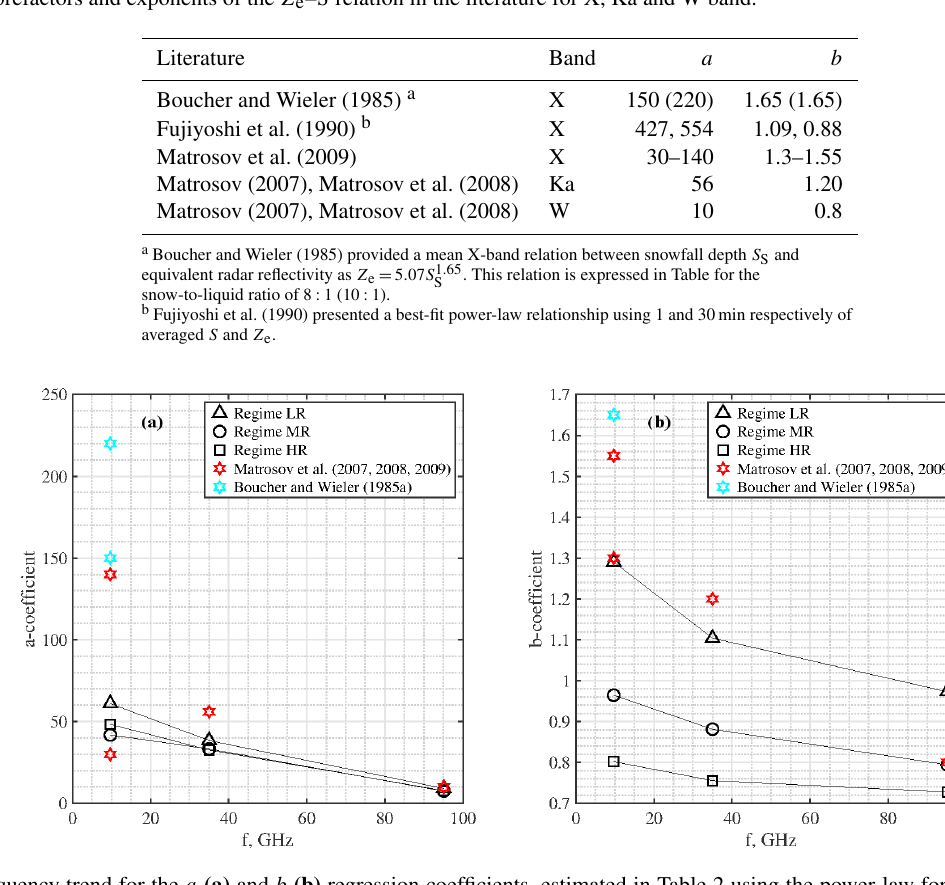
minimum and maximum values within the same averaging time interval of 5 min. A total of 8.33 % of the measurements (black circles in Fig. 8b and c) at the beginning of the event correspond to the MR snow data (0 % for X band, 8.33 % for Ka/W band) and they are disregarded since the variation in- dex (defined as the ratio between minimum–maximum vari- ability interval and its mean value) is considered to be too high. The different colored lines refer to Z e , simulated us- ing TMM from PIP data with a variable aspect ratio r s be- tween 0.2 and 1 with a step of 0.2. The smaller value r s = 0.2 (red line) indicate very oblate particles, whereas r s = 1.0 (blue line) correspond to spherical snowflakes. By